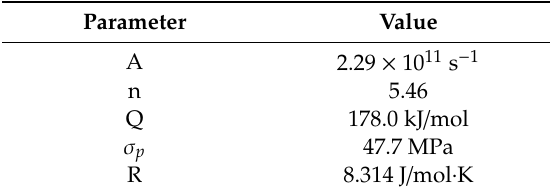
Table 2. 2024 aluminum alloy material parameters